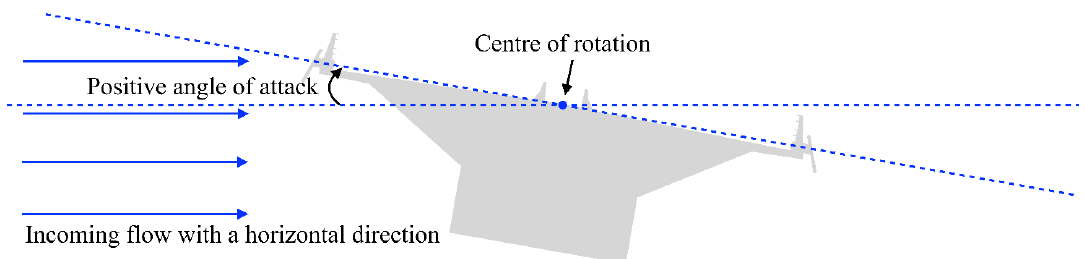
Figure 5. Sign convention of the angle of attack.